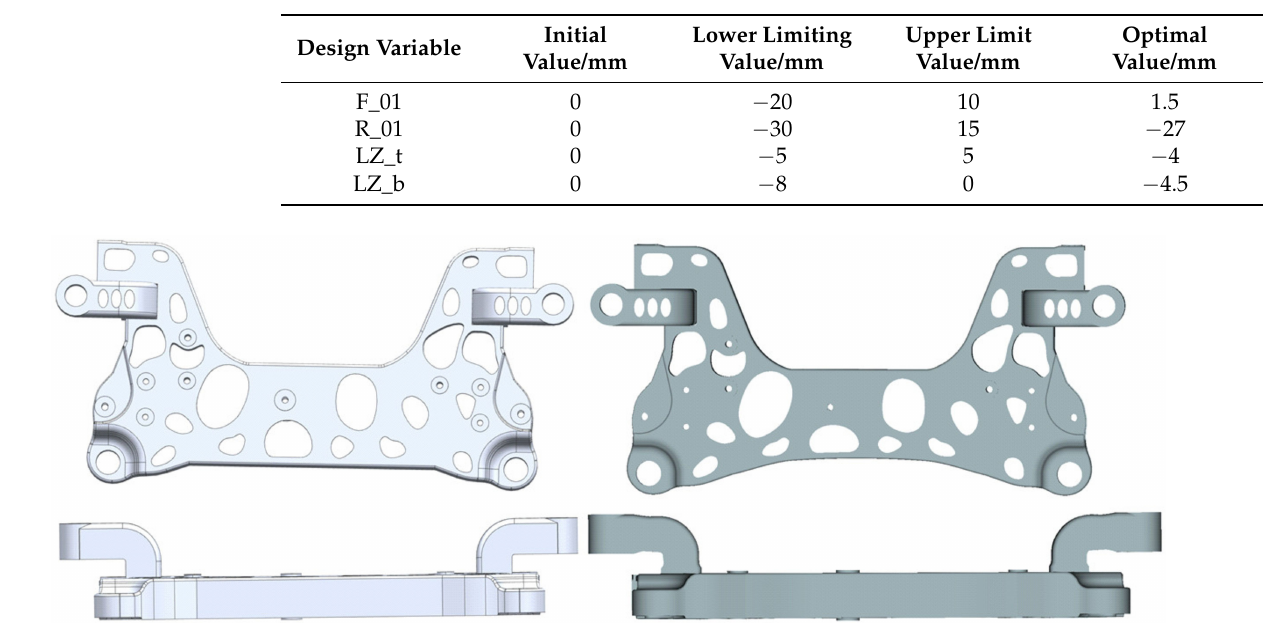
Table 5. Comparison of variable data before and after optimization.